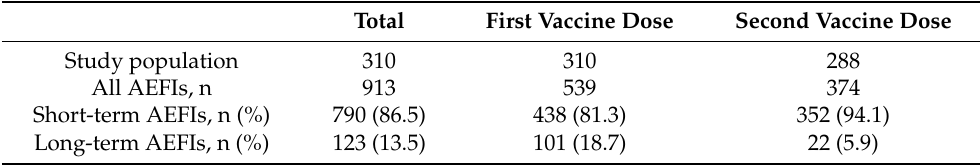
Table 2. Distribution of Adverse Events Following Immunization (AEFIs) by time of occurrence (short- and long-term) and vaccine’s